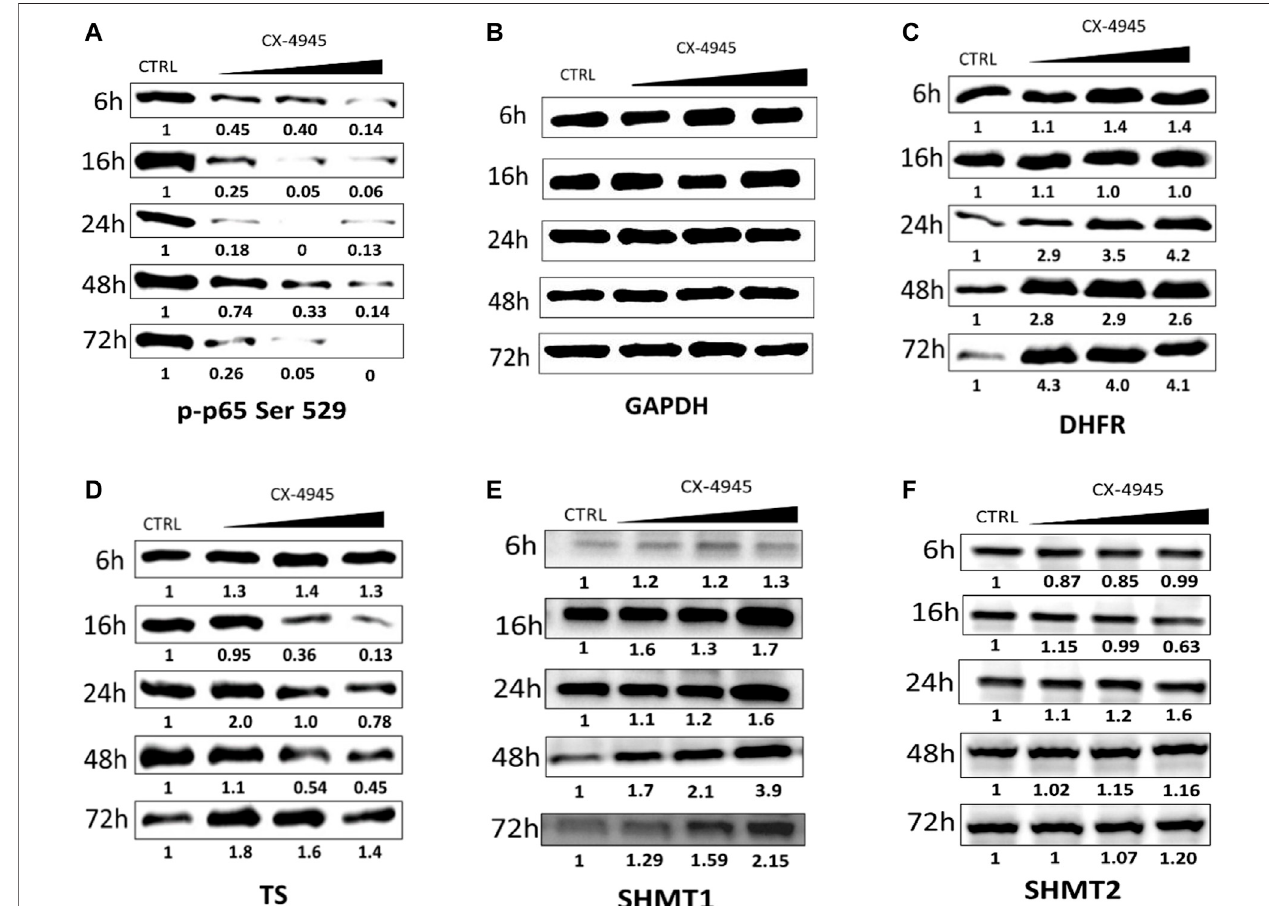
FIGURE2| TheeffectofCX-4945onthelevelofp-p65Ser529(nuclearfactorkappa-light-chain-enhancerofactivatedBcells),DHFR,TS,SHMT1,andSHMT2in CCRF-CEM.WesternblotanalysisofthefollowingproteinsinthecrudeextractsobtainedfromCCRF-CEMafter6,16,24,48,and72 hoftreatmentwith2,4,and8 µM CX-4945: (A) p-p65Ser529; (B) GAPDHwasusedasaloadingcontrolforeachsample; (C) DHFR; (D) TS; (E) SHMT1;and (F) SHMT2.Preparationofcellextractsand protein detection aredescribedin Materials and Methods . Densitometry quanti fi cations for each tested protein werecalculated withuntreatedcells (CTRL) serving as the reference point showing relative protein